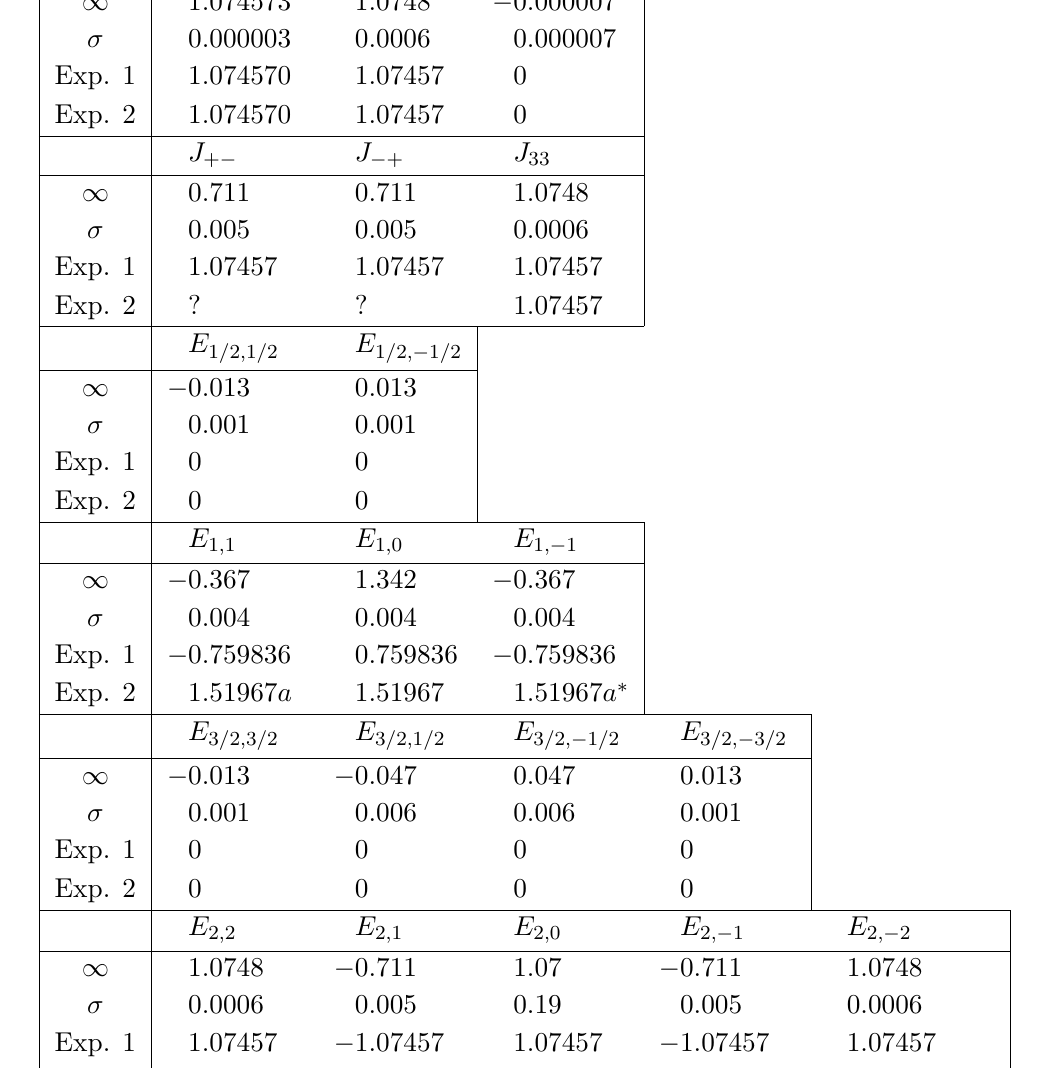
Table 22 . Extrapolations of a real exotic solution in the k = 4 model with J = 1 boundary conditions. There are two sets of expected values, the first one is for 1-brane with θ = 0 and the second one for the boundary state (3.4) from [39] with J seem to match either of